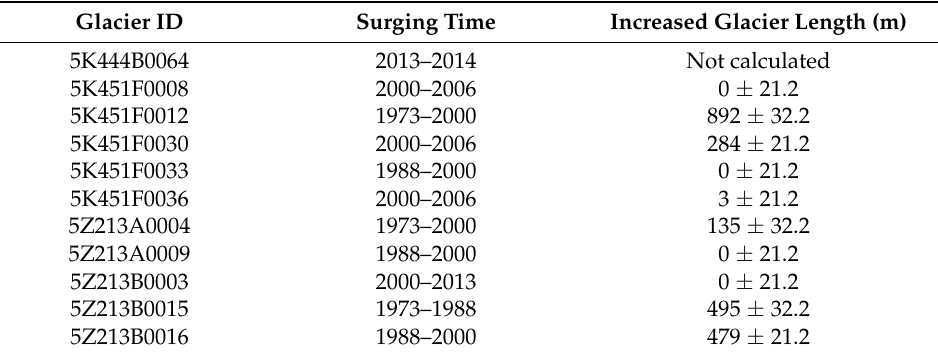
Table 4. Surging glaciers in Geladandong Peak region.